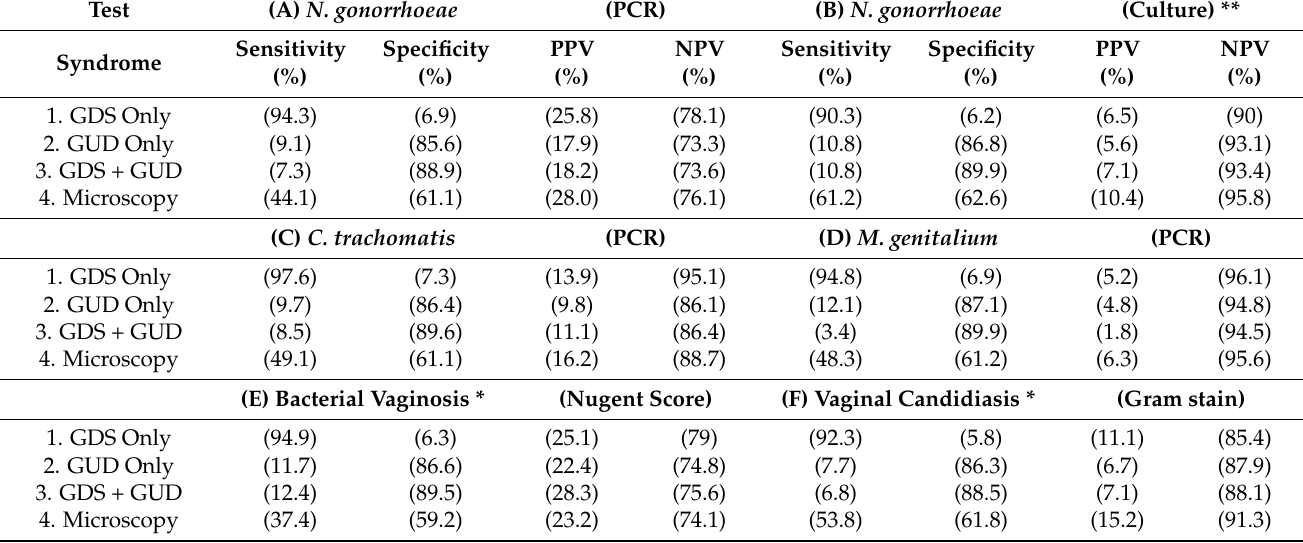
Table 2. Performance Characteristics of Syndromes as Compared with Laboratory Results for Detec- tion